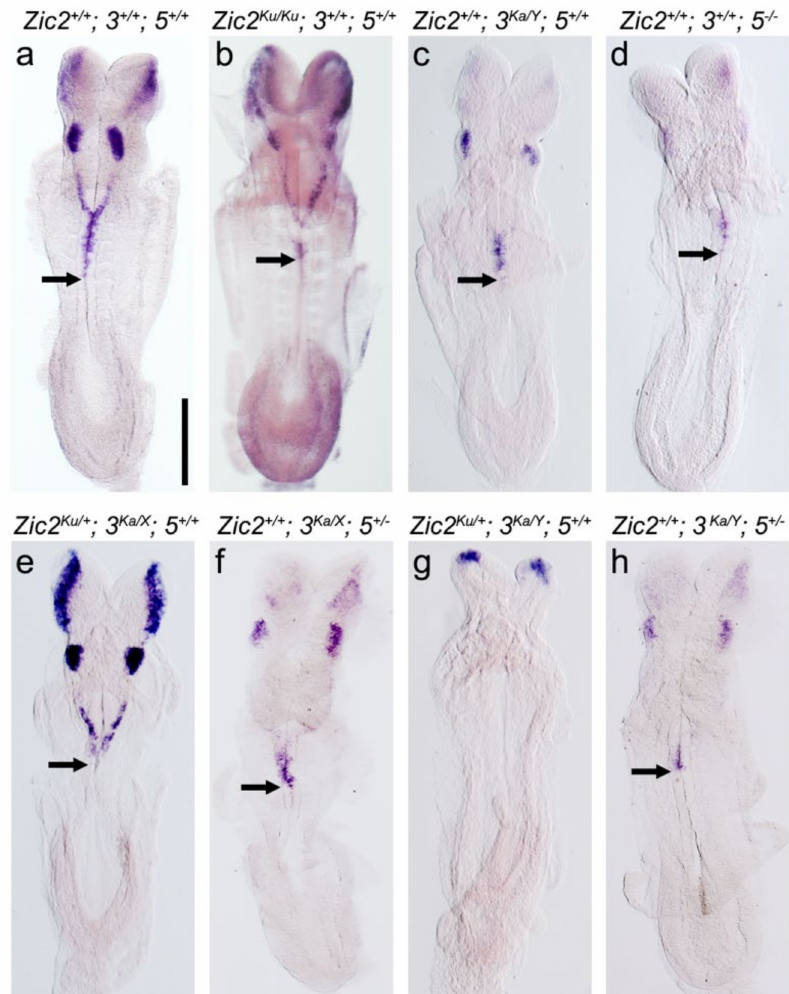
Figure 2. The Zic genes co-operate during murine neural crest cell specification. ( a – h ) Dorsal view of 8-somite stage murine embryos of the genotypes shown, following WMISH to Foxd3 (anterior to the top). The black arrow marks the distal extent of Foxd3 expression. The genotype is shown at the top of each panel and is abbreviated such that the Zic gene symbol is shown only once per panel. The complement), Zic2 —MMu 14: (122712796..122717740), and Zic3 —MMu X: (57075988..57081990)